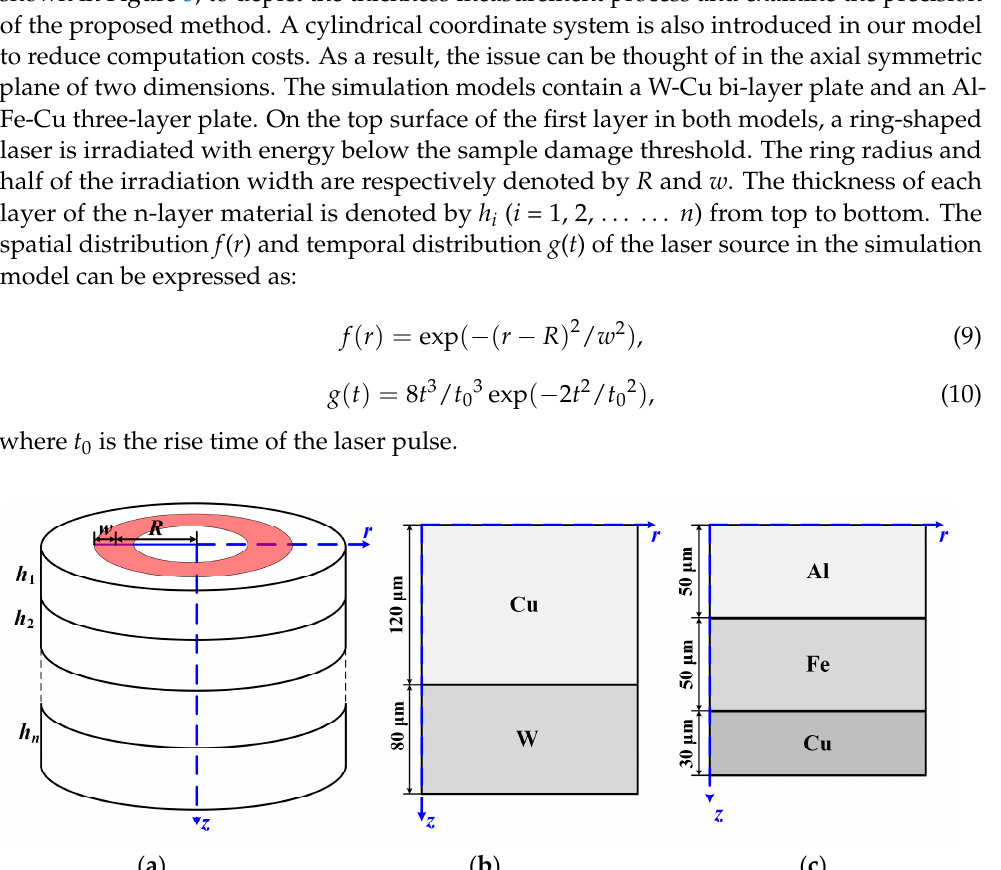
Table 1. Material parameters used in simulation cases.